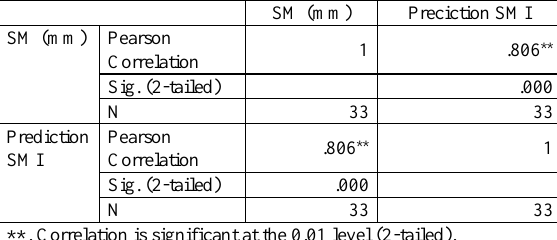
Table 4. Correlations between the ground truth measurement and PSMI